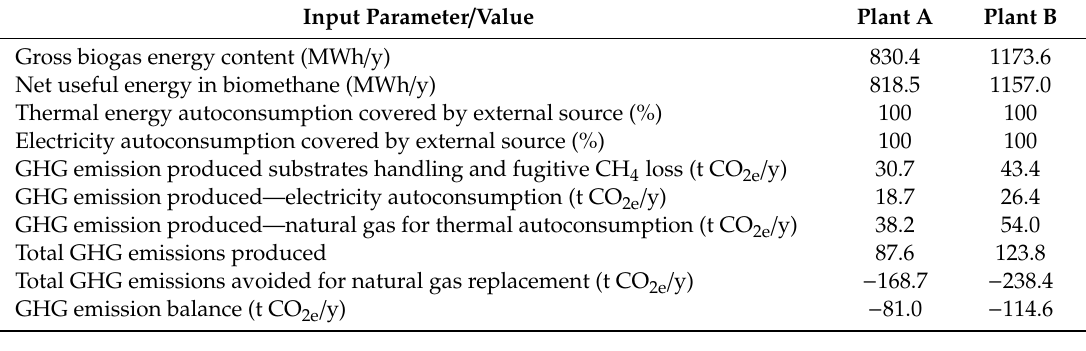
Table 7. Output of the biomethane simulation with the MCBioCH4 model.